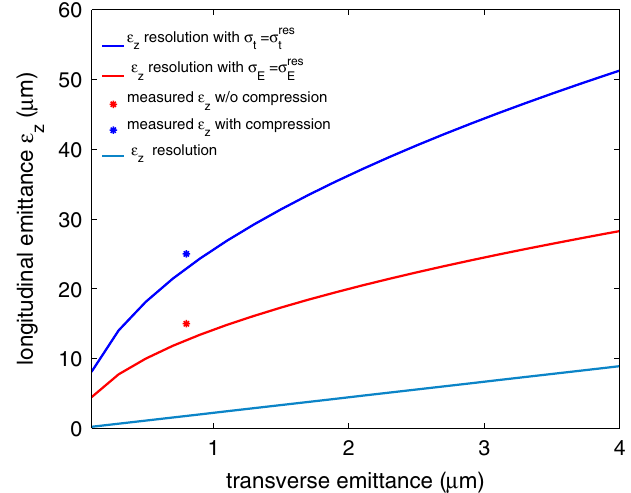
FIG. 4. Comparison between measured longitudinal emittance and calculated system resolution. The three curves represent minimum longitudinal emittance measurable as a function of beam transverse emittance. The cyan curve represents the values we would measure for a zero beam longitudinal emittance. The red (blue) curve represents the case in which only the energy (time) resolution is hit. The blue (red) dot represents measured longitudinal emittance for (un)compressed beam where one expects to have a pulse duration (energy spread) smaller than the system